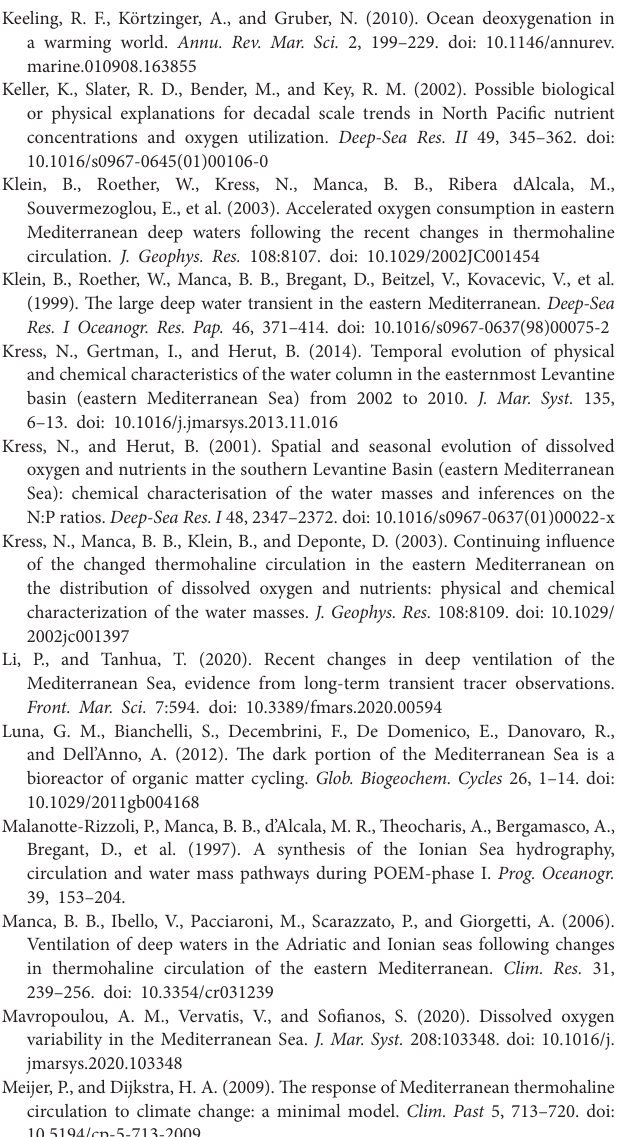
Supplementary Figure 1 | Box Whisker plot showing the interquartile range (25–75th percentile) of the bacterial production measurements. The mean value is shown as a solid